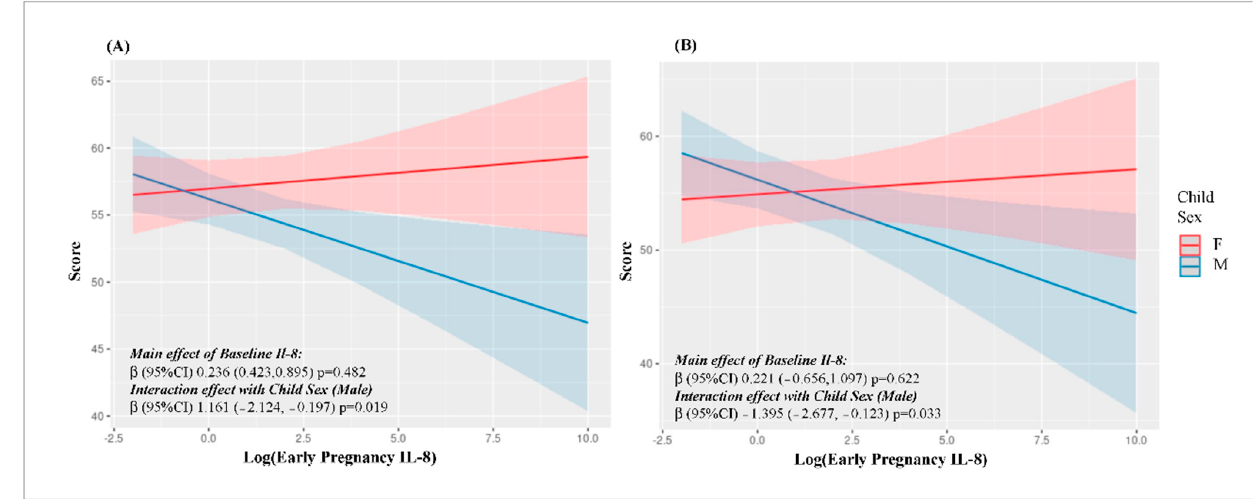
Figure 2. Interaction between log transformed IL8 levels in the first and third trimester and sex with ( A ) Personal-Social and ( B ) Problem-Solving skills at Age Three.